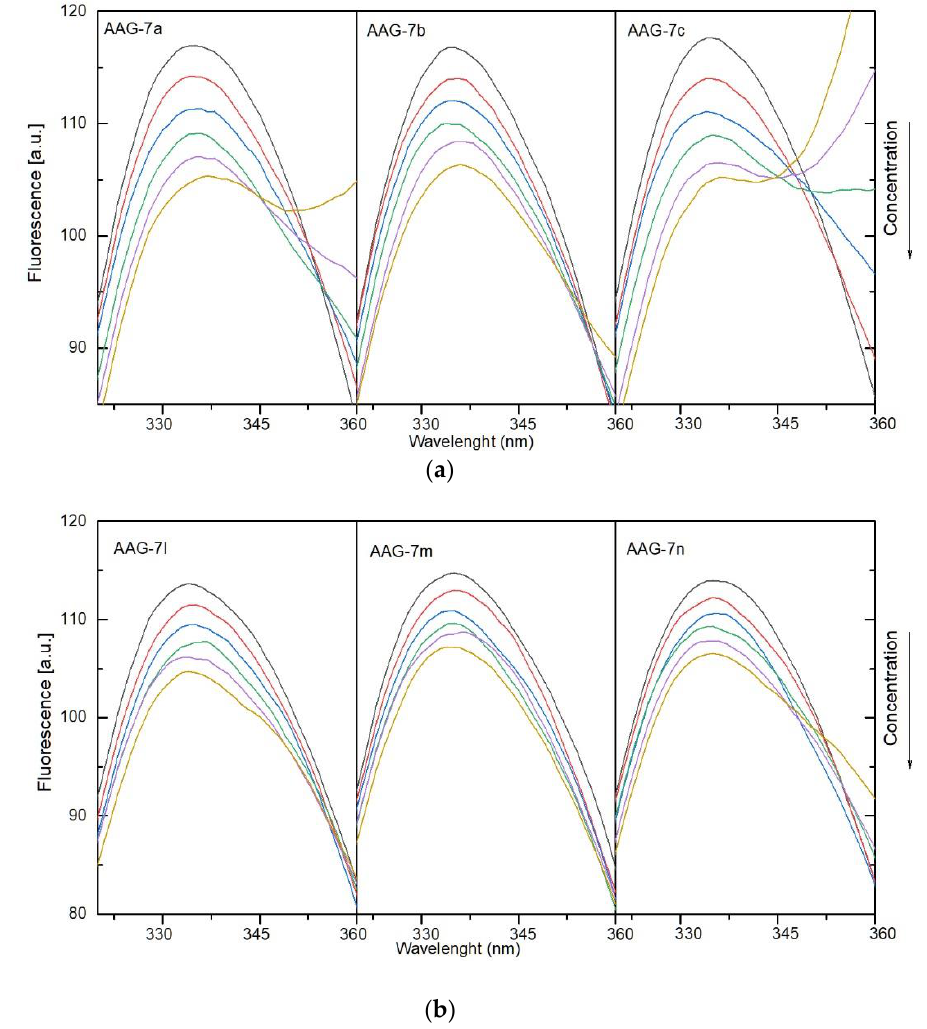
Figure 7. ( a ). Fluorescence quenching spectra of alpha-1-acid glycoprotein (AAG) in the presence of different concentrations of compounds 7a – 7c (T-297 K, λ ex = 280 nm). The concentration of AAG was 1.0 µM, the concentration of 7a – 7c 0, 0.4, 0.8, 1.2, 1.6, and 2.0 µM. ( b ). Fluorescence quenching spectra of alpha-1-acid glycoprotein (AAG) in the presence of different concentrations of compounds 7l – 7m (T-297 K, λ ex = 280 nm). The concentration of AAG was 1.0 µM, the concentration of 7l – 7m 0, 0.4, 0.8, 1.2, 1.6, and 2.0 µM. Table 8. The Stern–Volmer constant K sv , quenching rate constant k q , binding constant K b , number of binding sites n, and thermodynamic parameters for the interaction of human serum albumin (HSA) with the compounds at different